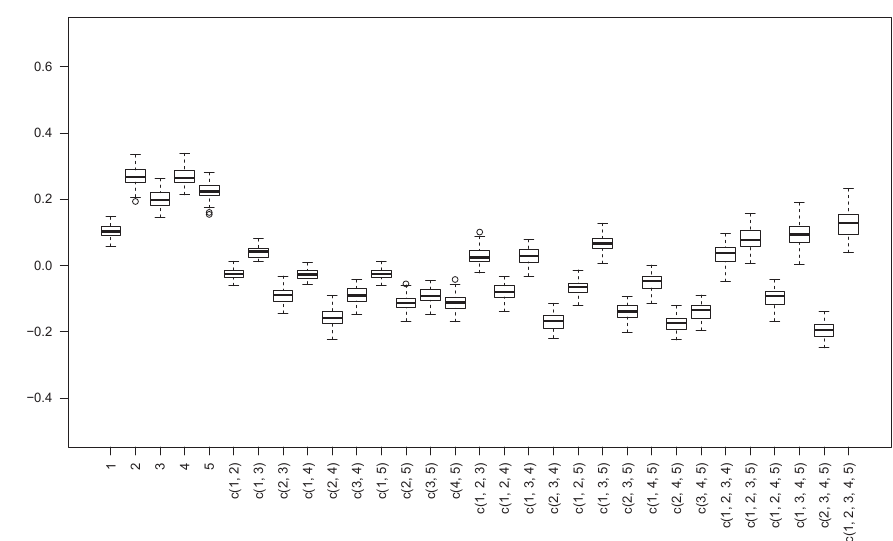
Figure 3. The nonadditivity index matrix N 3 by Algorithm